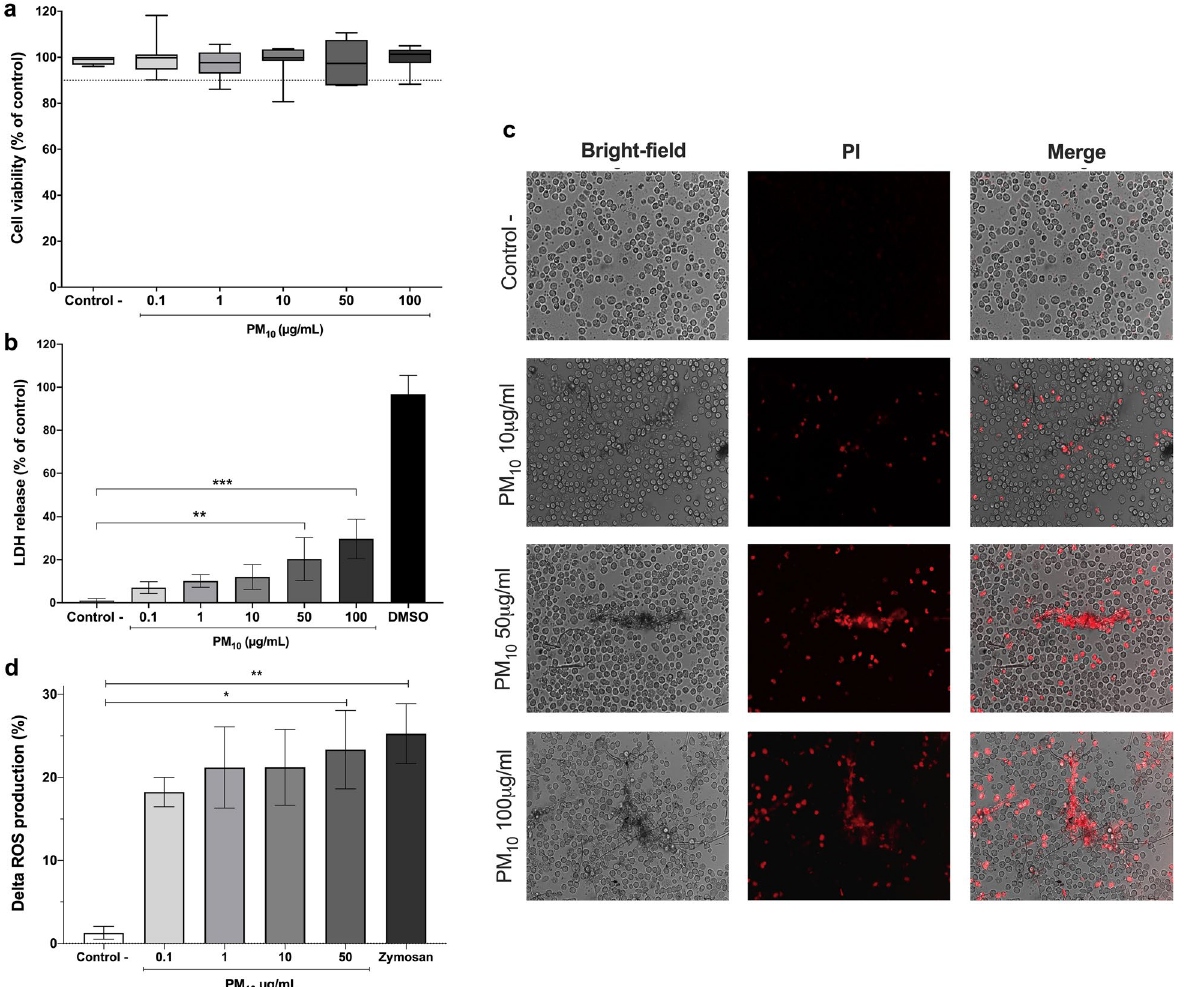
Figure 1. Cytotoxic effects of PM 10 and ROS production in PMNs. ( a ) Cell viability assay by MTT and ( b ) LDH release in PMNs exposed to different concentrations of PM 10 (0.1, 1, 10, 10, 50 and 100 µg/mL) for 5 h. Negative control (culture medium); positive control (DMSO). ( c ) Necrotic effects in PMNs exposed to different concentrations of PM 10 (10, 50, and 100 µg/mL) for 30 min by PI staining. Photographs of each slide were observed at 200X magnification. ( d ) Intracellular ROS production in PMNs exposed to different concentrations of PM 10 (0.1, 1, 10, and 50 µg/mL) for 30 min, determined by flow cytometry. Negative control (culture medium); positive control (zymosan). ROS levels are presented as the mean fluorescent intensity of DHR of treated cells relative to control. All data are represented as mean ± SEM of 8–14 healthy donors; *p < 0.05; **p < 0.01; ***p < 0.001, by Kruskal–Wallis analysis with Dunn’s post hoc